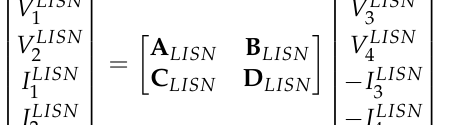
Figure 6. Calculation of the open-ended voltages of the Thevenin circuit in the PLC Tx model. To evaluate open-ended voltage sources, the voltages at the LISN’s signal ports by means of an oscilloscope. The spectra of the time-domain measured voltages are then evaluated by the fast Fourier transform (FFT). The obtained frequency-domain voltages are hereinafter labeled as V LISN